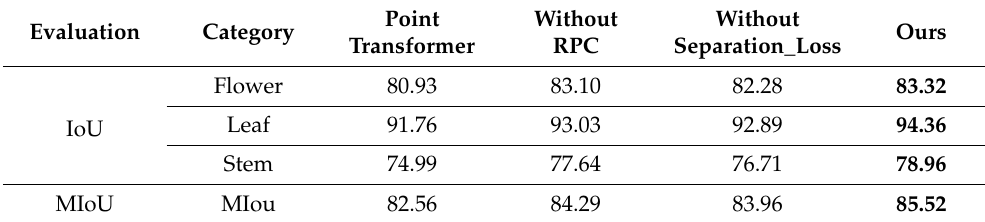
Table 2. Ablation study on ROSE_X